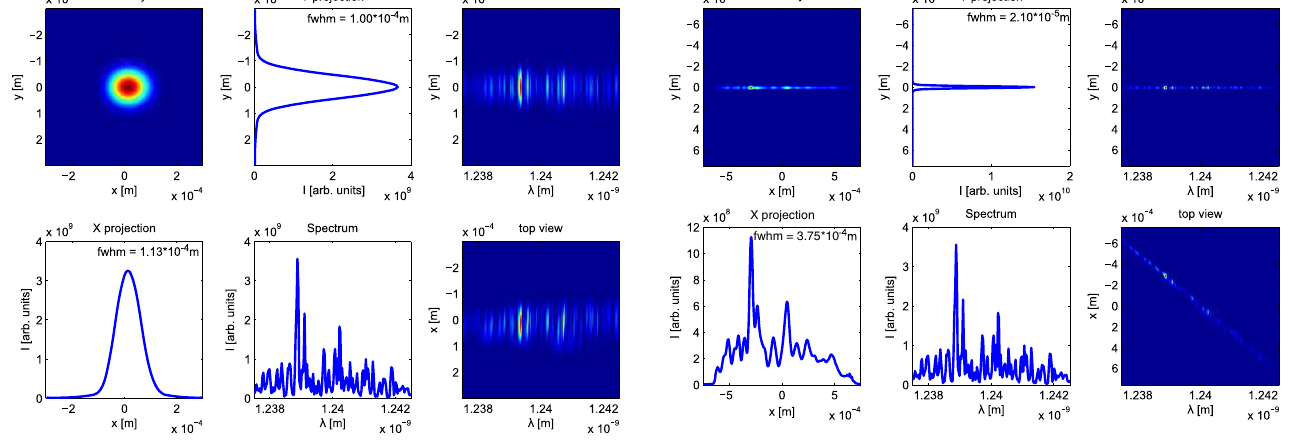
FIG. 8. Radiation distribution at the end of SASE undulator in frequency domain. Left figure in first row is the transverse intensity distribution. Right figures represent projections of beam distributions at different wavelengths. Note that at this point all wavelengths are transversely overlapped. Here and below spatial- frequency domain is represented in transverse coordinates x , y , and λ ¼ c= ω .